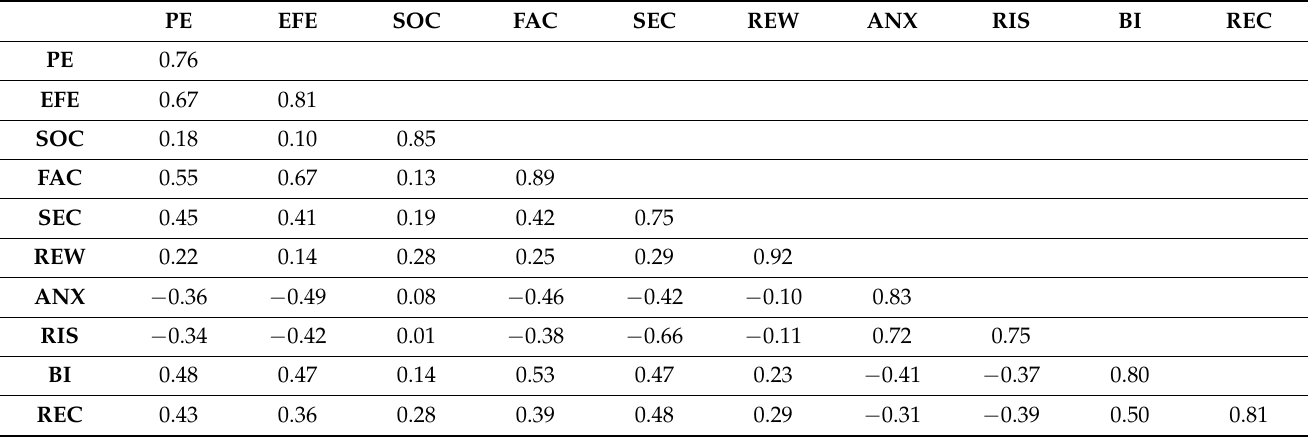
Table 4. Inter-correlation and square roots of AVE.